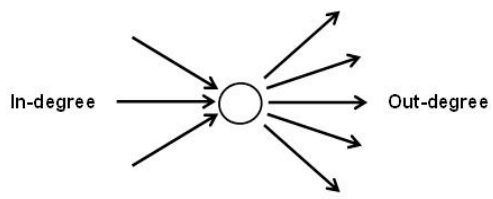
Figure 8. Predecessors and successors sccording to graph theory.